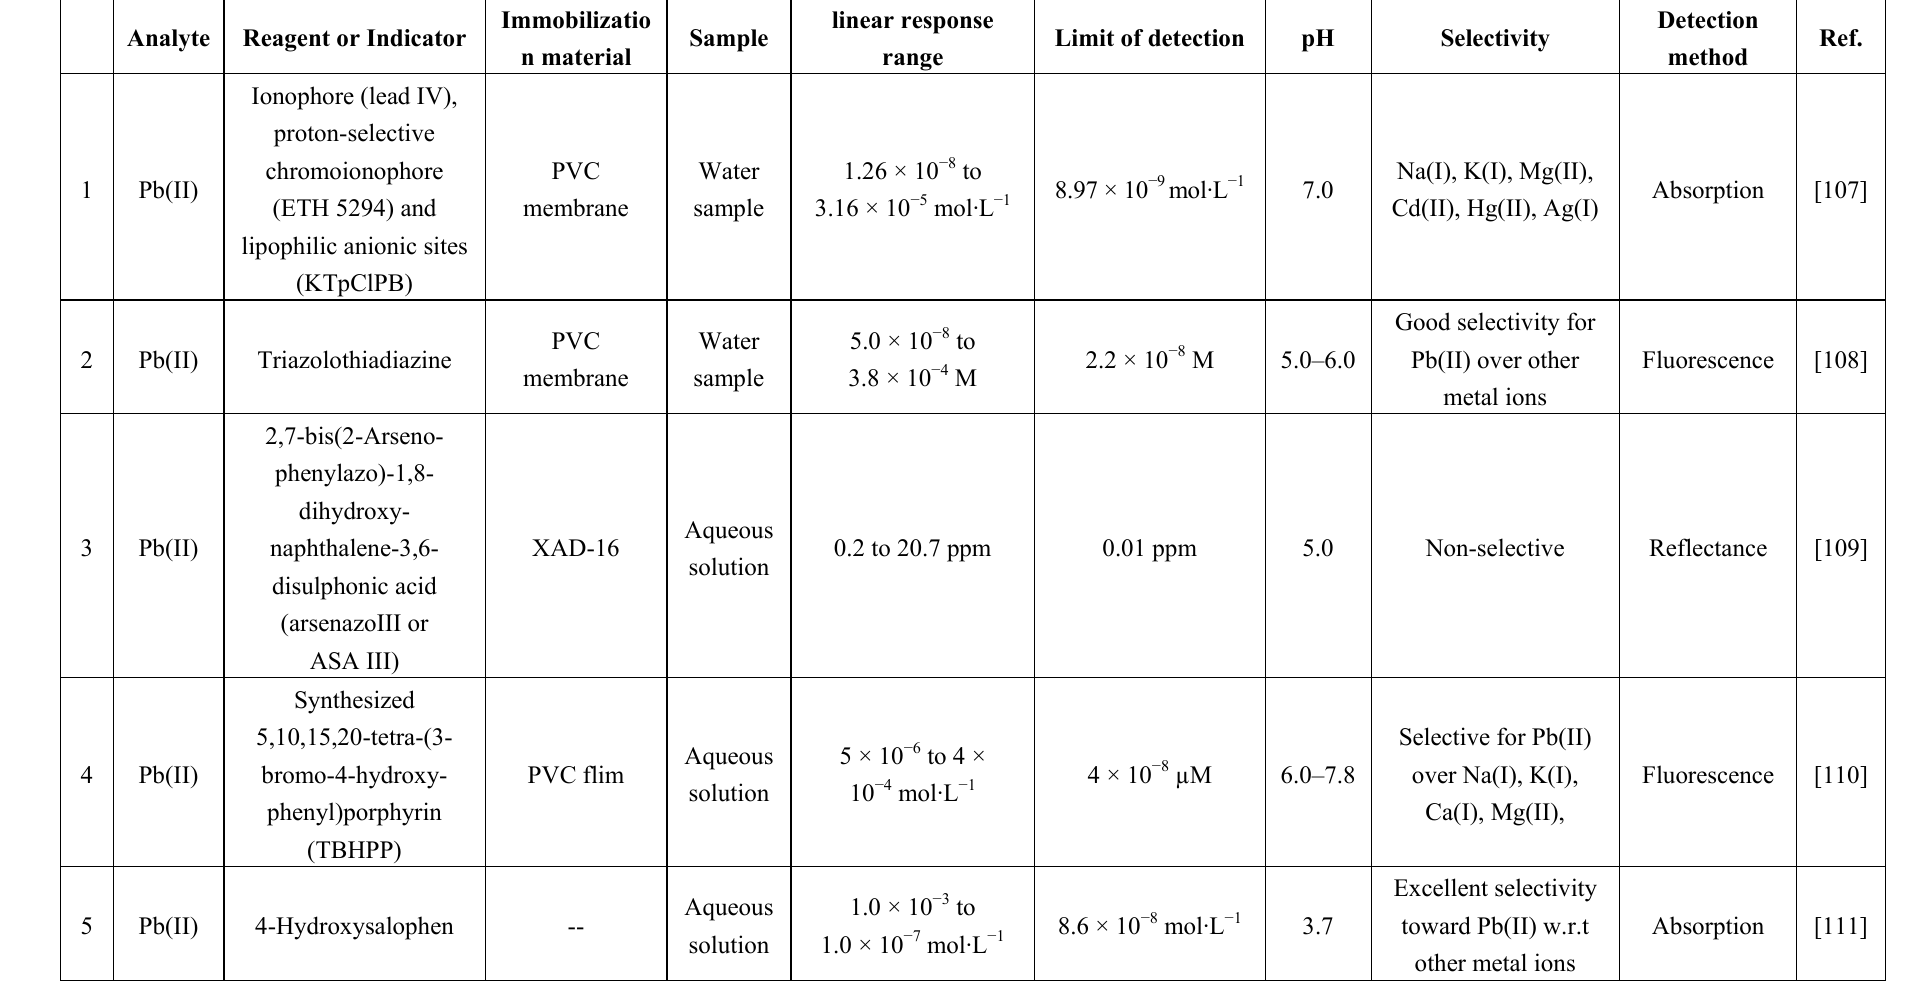
Table 1. Recently reported optical chemical sensors for metal